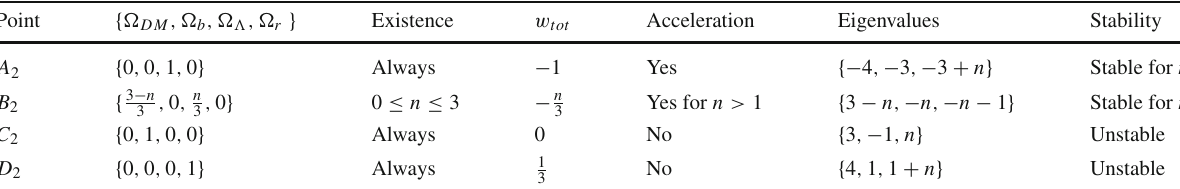
Table 2 Critical points and physical quantities for Case B Point